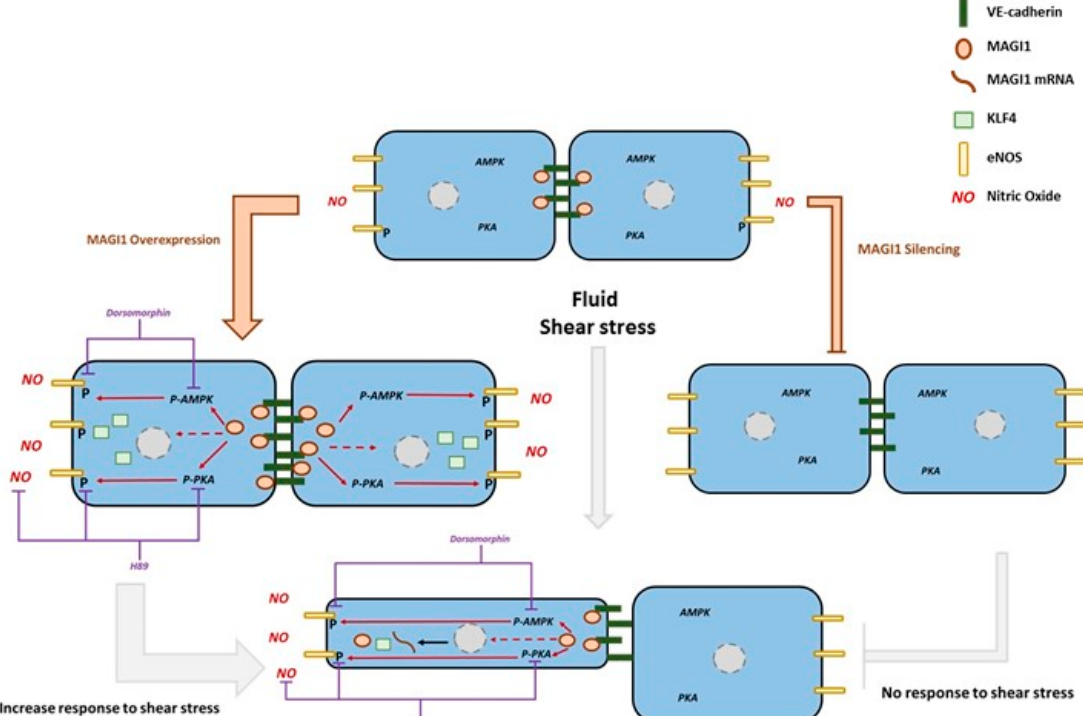
Figure 6. Proposed model. MAGI1 localizes at cell-cell contacts with VE-Cadherin. Shear stress induces MAGI1 expression, which promotes endothelial cell alignment to flow, KLF4 expression, Ser 1177 eNOS phosphorylation and NO production. MAGI1 induced Ser 1177 eNOS is mainly mediated through PKA and to a lesser extent AMPK. AKT or CAMKII, two additional kinases also reported to phosphorylate and activate eNOS, are not involved in MAGI1-mediated Ser 1177 eNOS